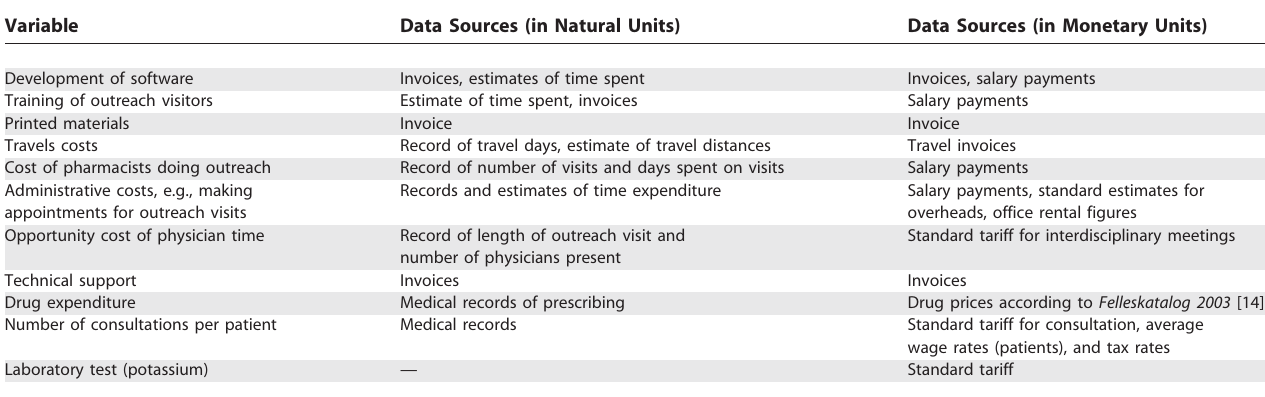
Table 2. Input Variables in Economic Analysis